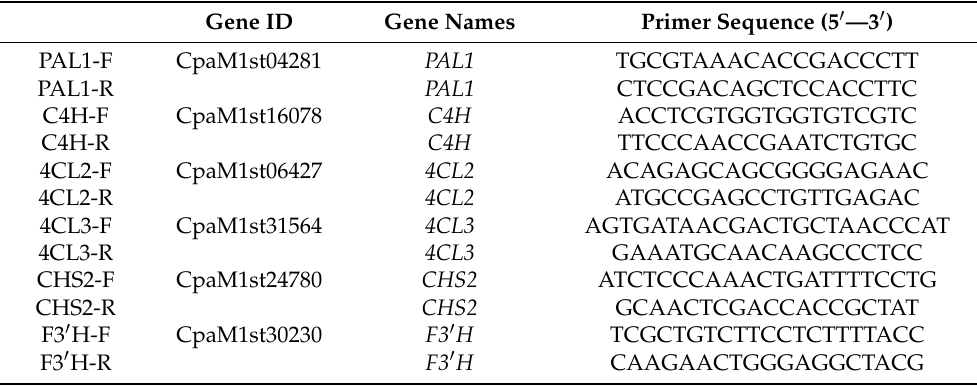
Table 3. Primers used for the quantification of screened genes’ expression levels by qRT-PCR. Gene ID Gene Names Primer Sequence (5 (cid:48) —3 (cid:48) )